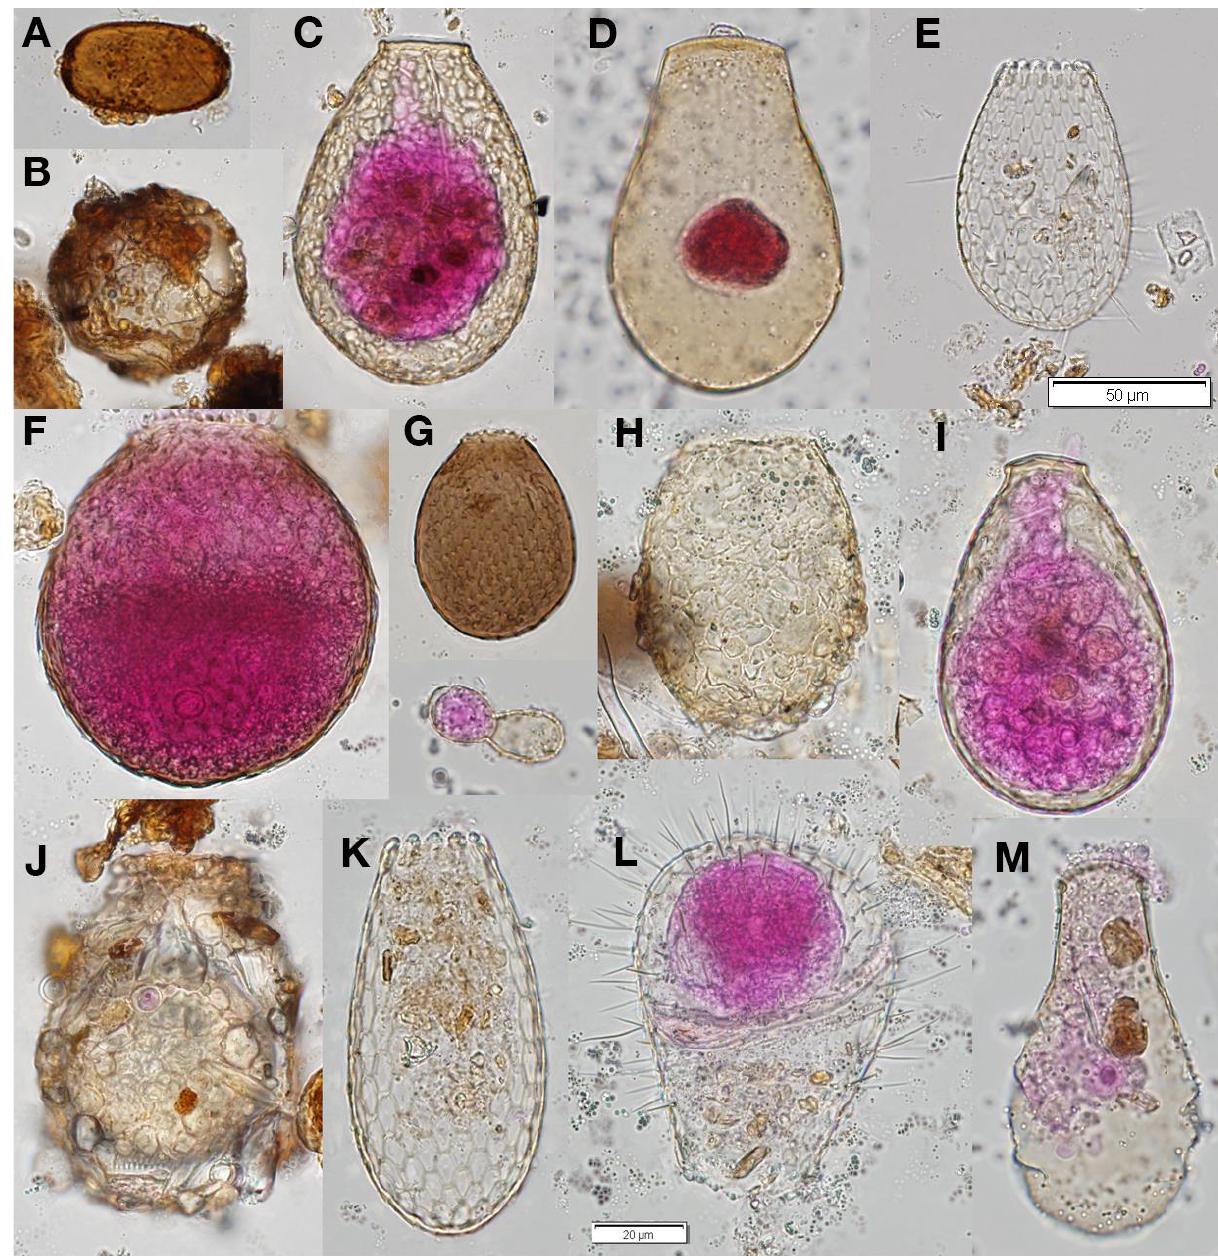
Figure 3. Light microscopy pictures (bright field and differential interference contrast) of selected testate amoeba species from the botanic garden (BG) and Bois-des-Lattes (BdL) peatlands. A: Archerella flavum , B: Difflugia globulosa (included in Phryganella acropodia type), C: Nebela collaris , D: Hyalosphenia papilio , E: Euglypha compressa , F: Assulina scandinavica (included in A. seminum type), G: Assulina muscorum , H: Heleopera sylvatica , I: Nebela tincta type, J: Difflugia cf. lucida , K: Euglypha cf. tuberculata , L: Euglypha cf. ciliata , M: Hyalosphenia elegans . Note the two scales used: images A–E were taken at 200× magnification, scale bar = 50 µm; images F–M were taken at 400× magnification, scale bar = 20